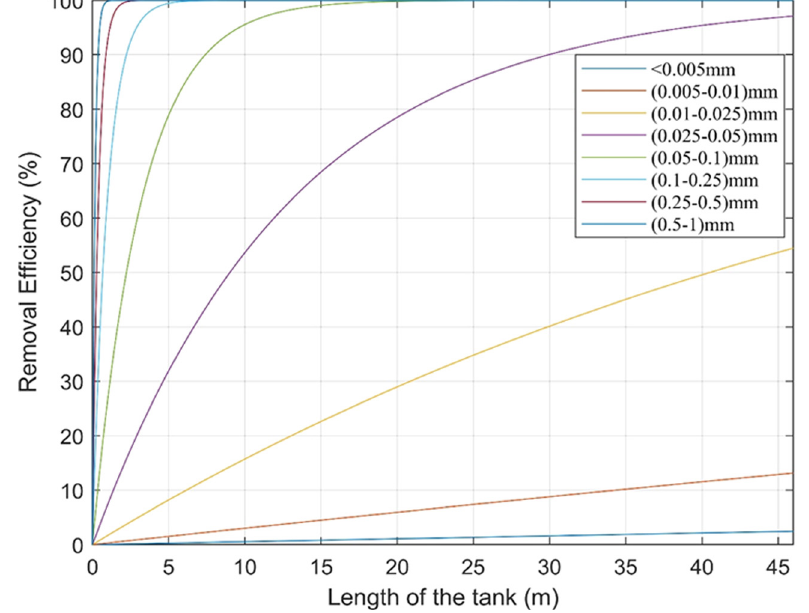
Figure 7: Removal e ffi ciency for each particle size of AL - Muthana sedimentation basin without fl occulation process.